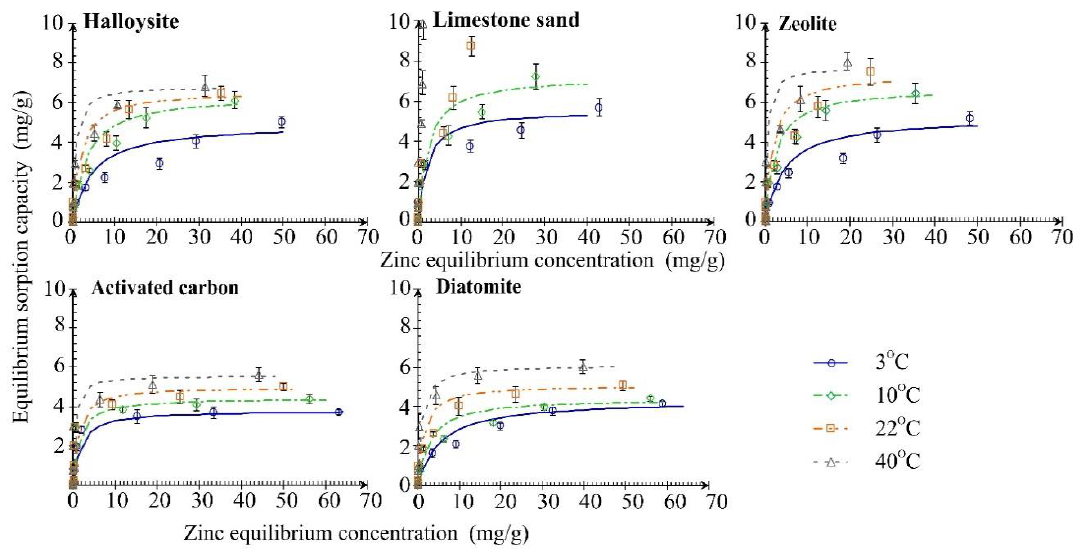
Figure 4. Adsorption isotherm of copper ions at 3 °C, 10 °C, 22 °C and 40 °C (error bars mark the standard deviation for n = 3; line - fitting of Langmuir isotherm).